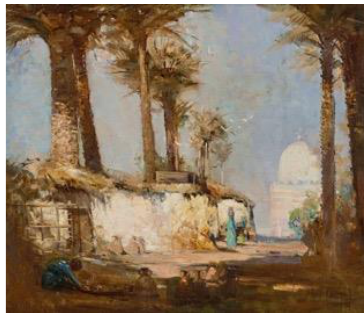
Figure 3. Arthur Streeton, Cairo , 1897, oil on canvas, 50.6 × 61.3 cm.